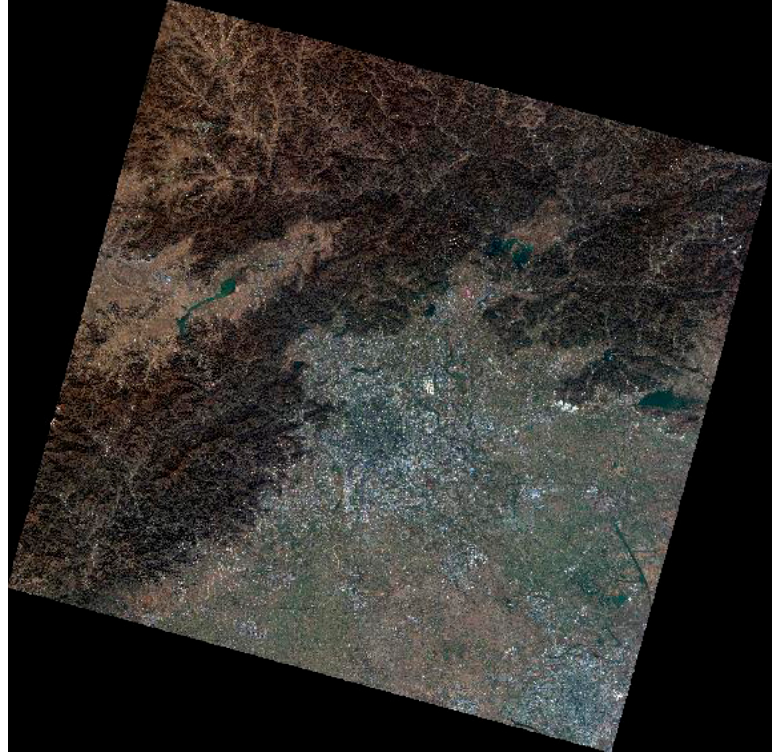
Figure 17. A scene of Gaofen-1 satellite that covers the Beijing area (true color composite).